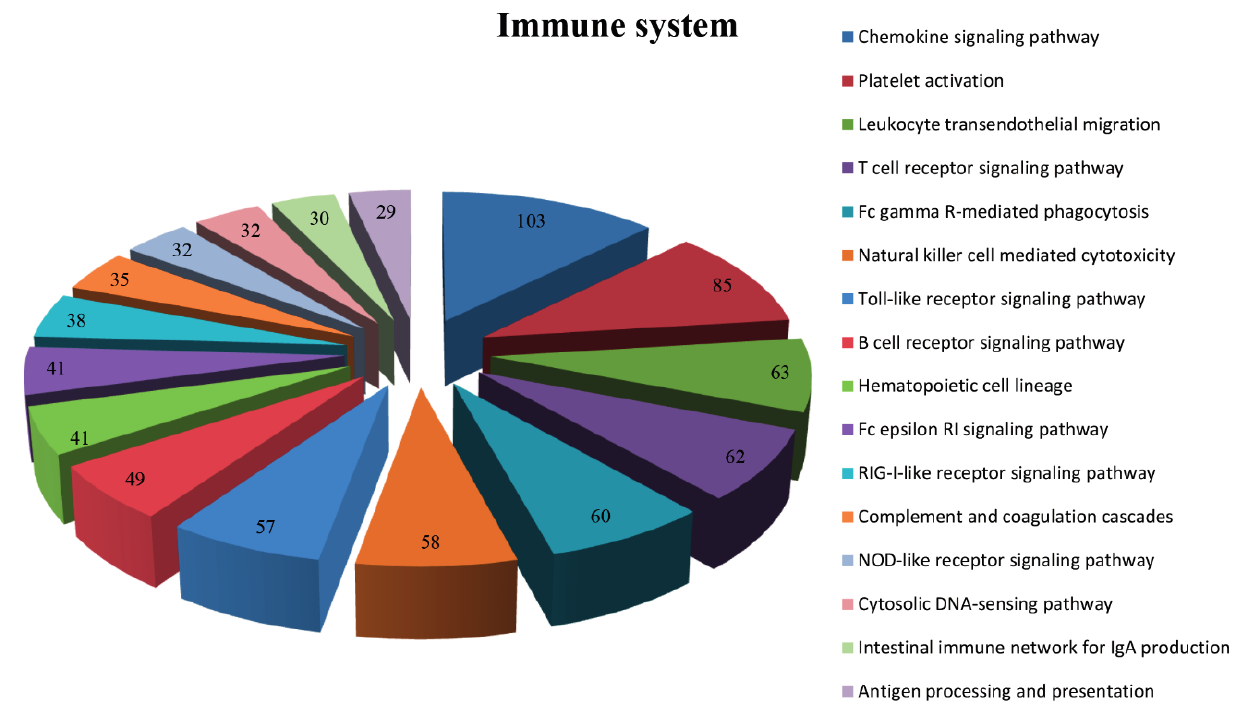
Figure 7. Distribution of unigenes in the immune system. In the immune system, 16 pathways were identified. A total of 456 unigenes were involved in the 16 immune system KEGG pathways. Each unigene may be grouped into more than one